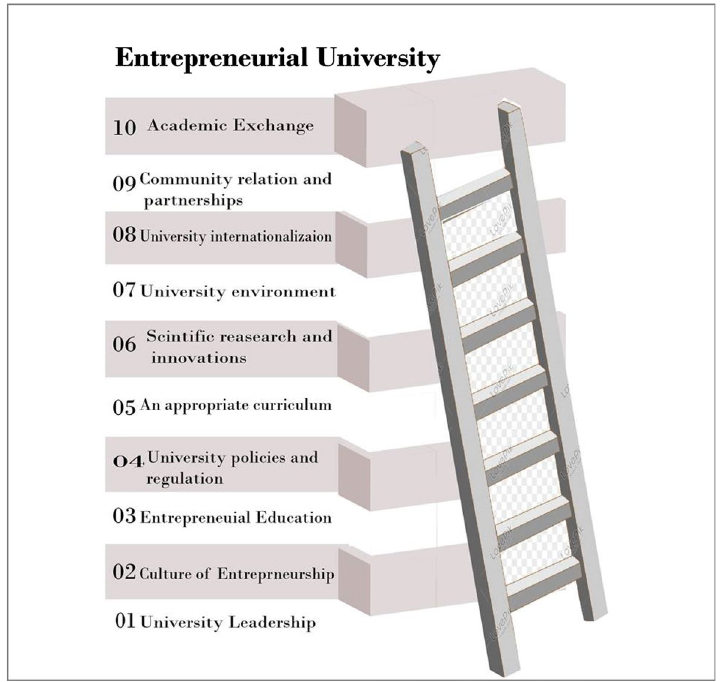
Fig. 5 Steps organized in ascending order and required for the transition of PPU into an entrepreneurial university. (Developed by the